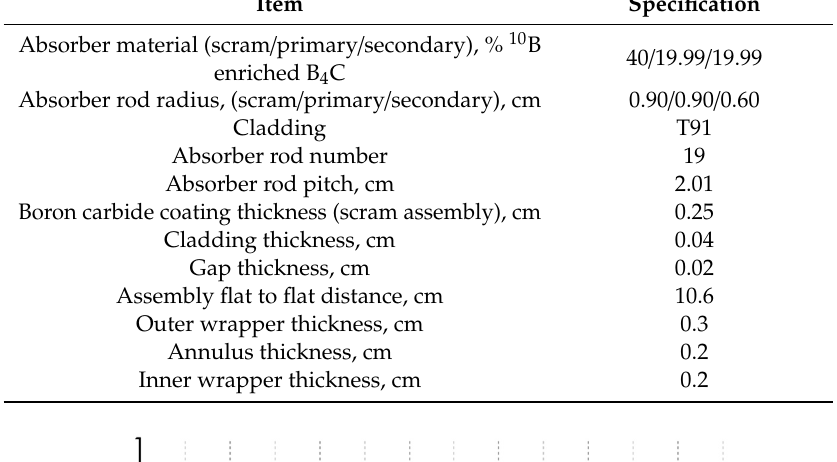
Table 3. Design parameters of the control and scram assemblies.